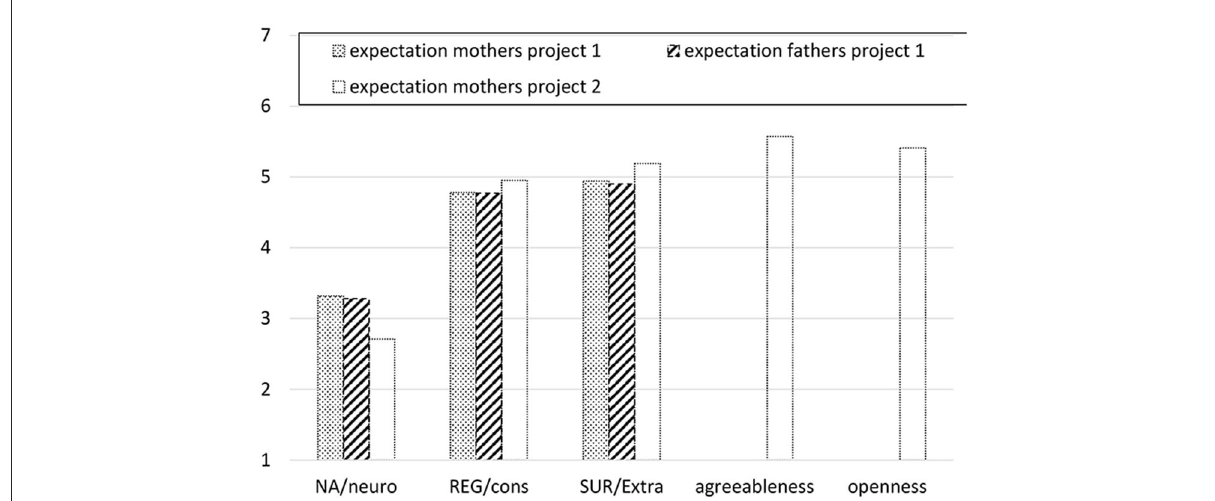
FIGURE2 Expected temperament and personality traits scores. NA, Negative affectivity; REG, Regulation; SUR, Surgency.